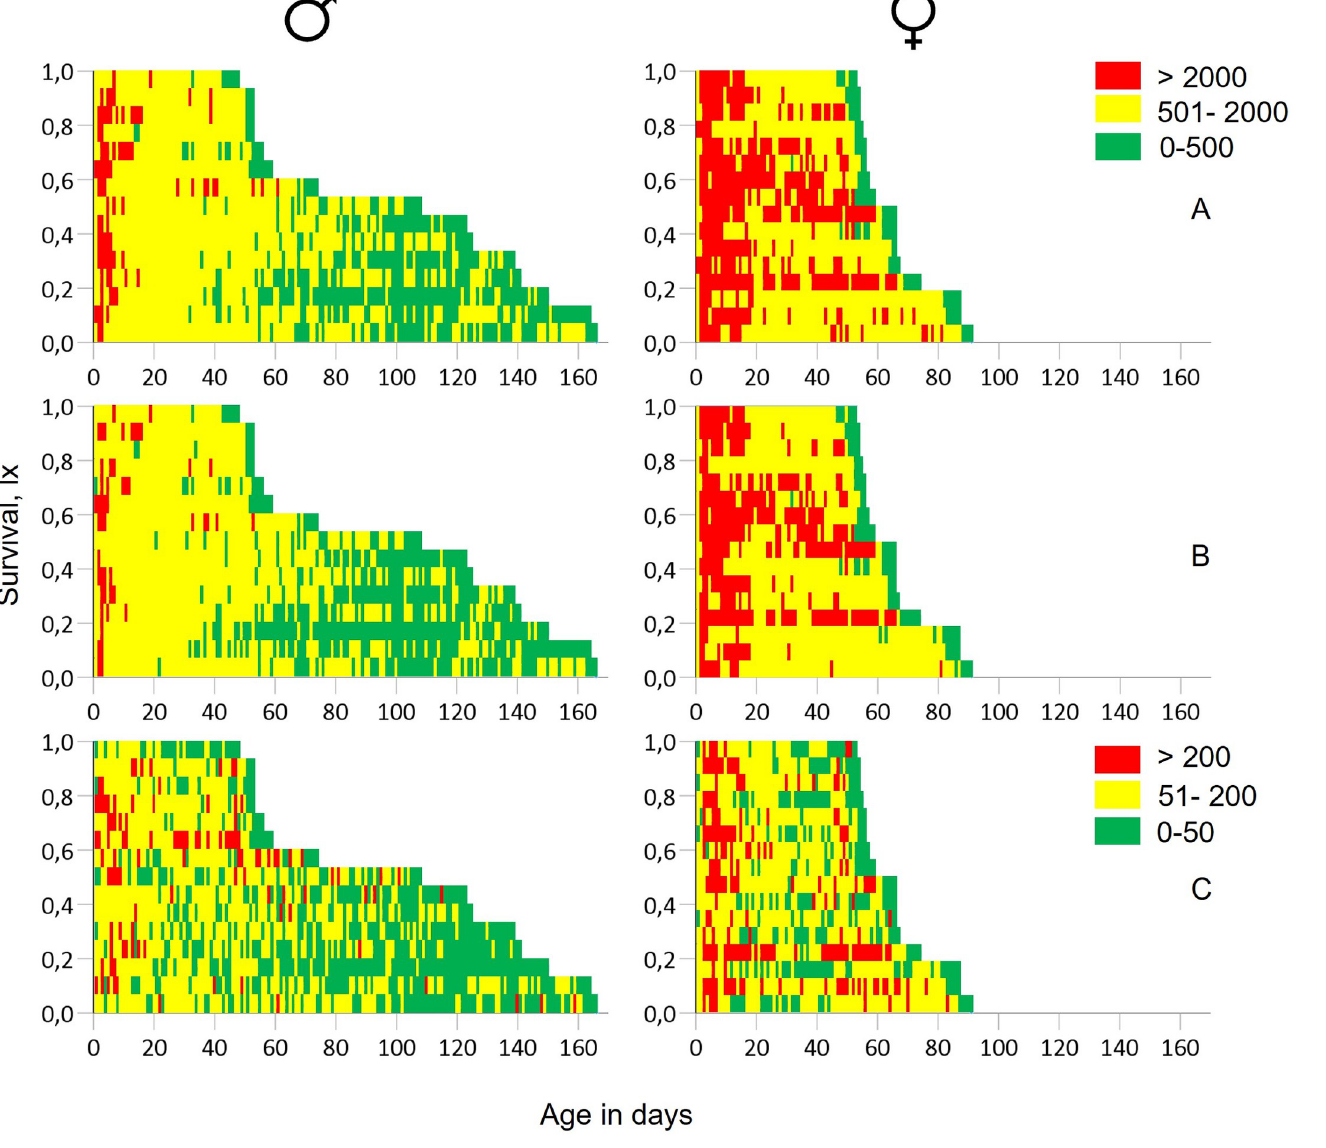
Fig 5. Event history diagram providing a detailed picture of the ages when activity was recorded during the 24h interval (A), daytime (B) and nighttime (C). Red: > 2000 movements during 24h and daytime and > 200 during nighttime, yellow: 501–2000 movements during 24h and daytime and 51–200 during nighttime, green: 0–500 movements during 24h and daytime and 0–50 during